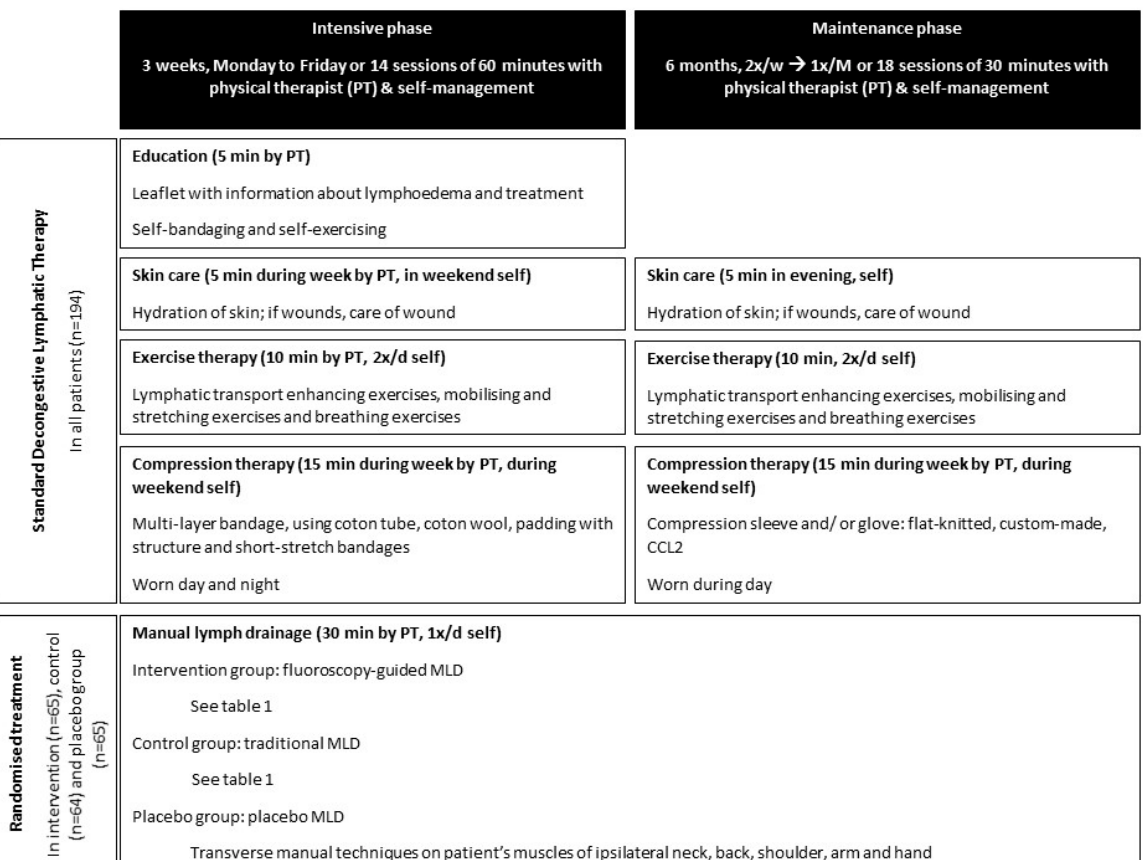
Figure 1. Overview of the intervention in the trial (PT = physical therapist; CCL = compression class; MLD = manual lymph drainage).